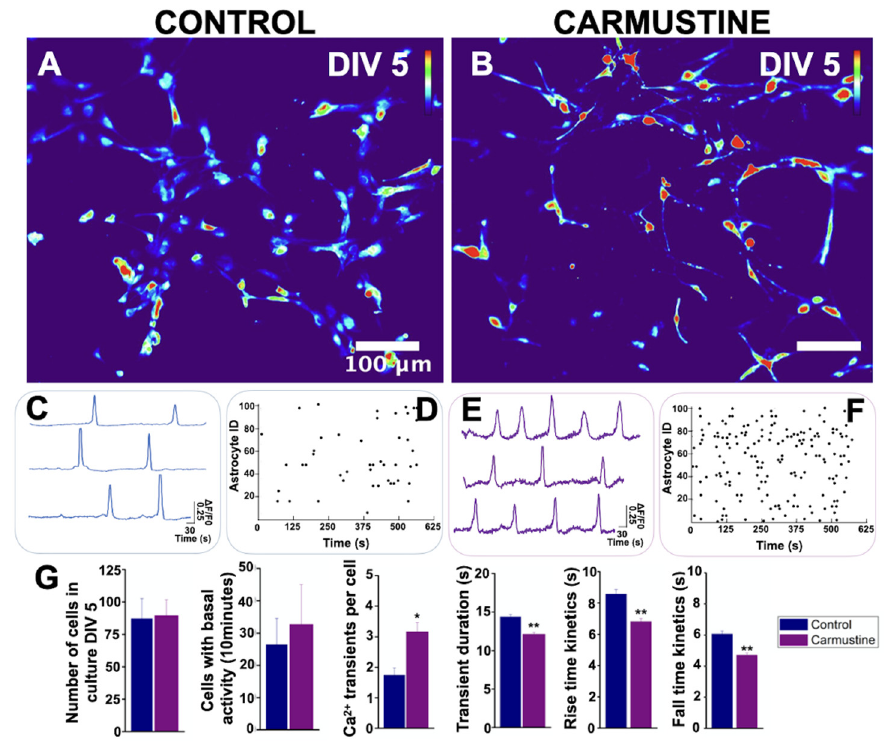
Figure 6. Basal activity of cerebellar astrocytes in culture. ( A , B ). Heat map of the maximum projection images of basal activity from primary cultures of cerebellar astrocytes at DIV5. Representative traces of basal activity of ( C ) control and ( E ) carmustine-treated mice. Contrast of the higher activity of astrocytes from carmustine treated mice. Raster plot of the basal activity of ( D ) control and ( F ) carmustine-treated astrocytes. The baseline activity of individual astrocytes is shown over time. The Y axis corresponds to the ID of each astrocyte and a dot indicates the time in which a calcium transient event occurred. ( G ). Comparative analysis between the control and the carmustine-treated group. Astrocytes from carmustine-treated mice culture presented more cells with spontaneous Ca 2+ activity, with a higher number of Ca 2+ transient events per cell. Astrocytes also showed shorter duration and reduced kinetics of rise and fall time of these events. An average of 87.25 ± 15.36 astrocytes responded to ATP at DIV5 culture, Control n = 4, 8 pups were used, 2 for each control culture; whereas 89.50 ± 12.29 astrocytes responded to ATP at DIV 5, Carmustine n = 4, 8 pups, 2 for each carmustine culture). Data are represented as the mean ± the standard error of the mean. * indicates significant difference ( p < 0.05) and ** indicates significant difference ( p < 0.001) both compared to the control group.